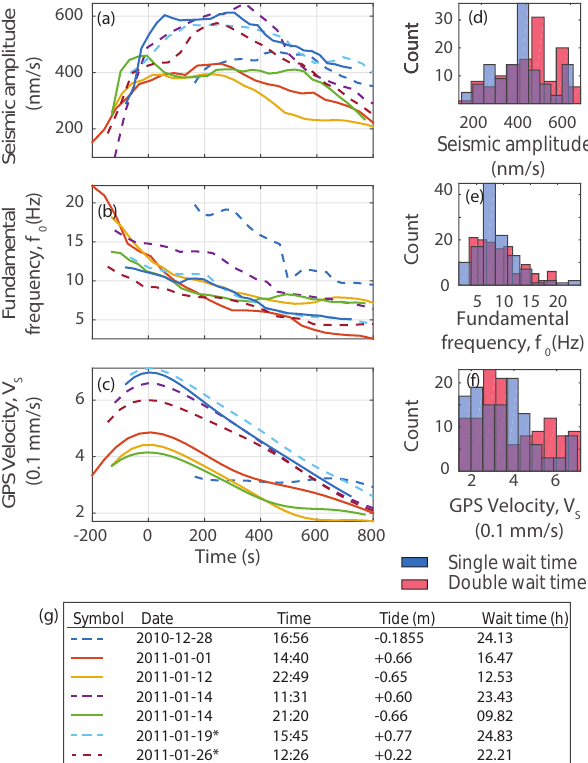
Figure 4. Time series (a–c) and histograms (d–f) of observed pa- rameters for six tremor episodes. Events with wait times greater than 17h (double wait time events) are shown with dashed lines and events with wait times less than 17h (single wait time events) are shown with solid lines. Collocated GPS data were not available at BB09 for the events marked with asterisks; data were used from the station BB02 for these